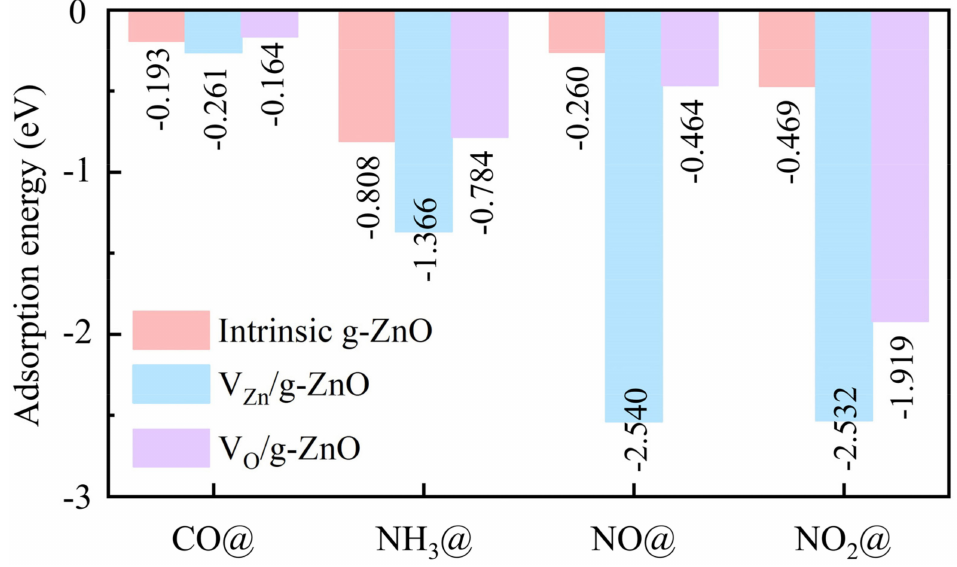
Figure 3. The absorption energy of gas molecules on intrinsic g − ZnO, V Zn /g − ZnO, and V O /g − ZnO